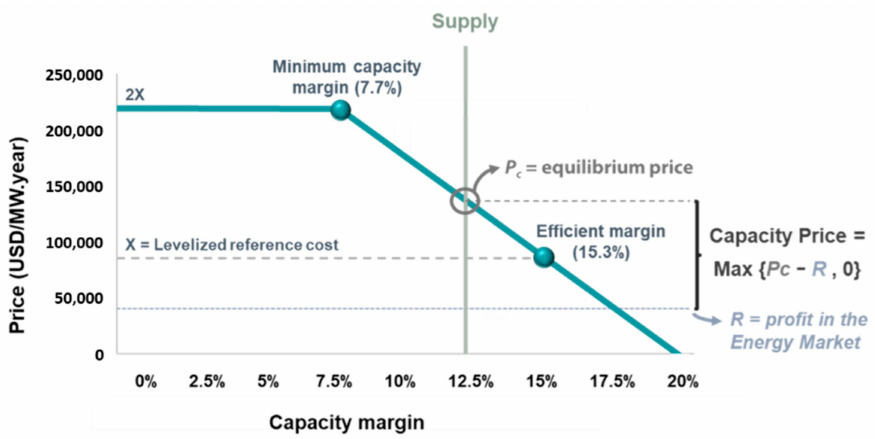
Figure 8. Reliability constraints in Mexico: capacity market price